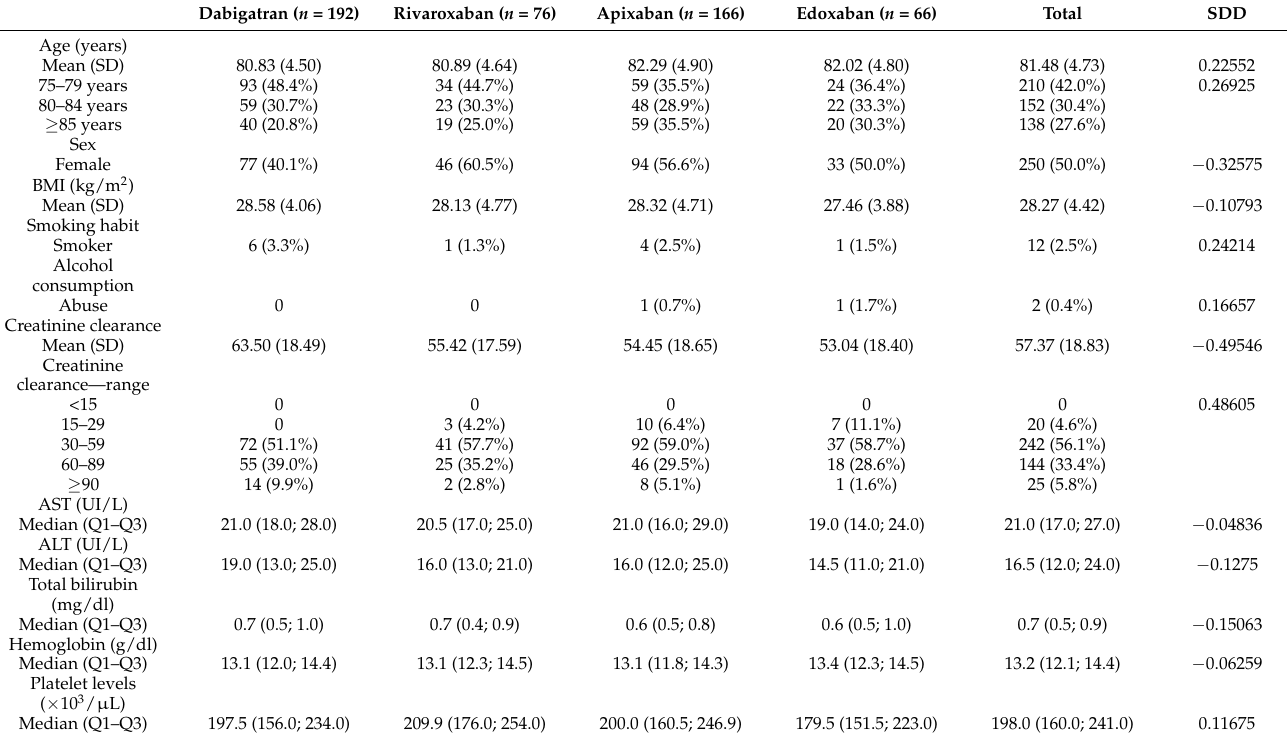
Table 1. Baseline sociodemographic characteristics and laboratory values according to current NOAC